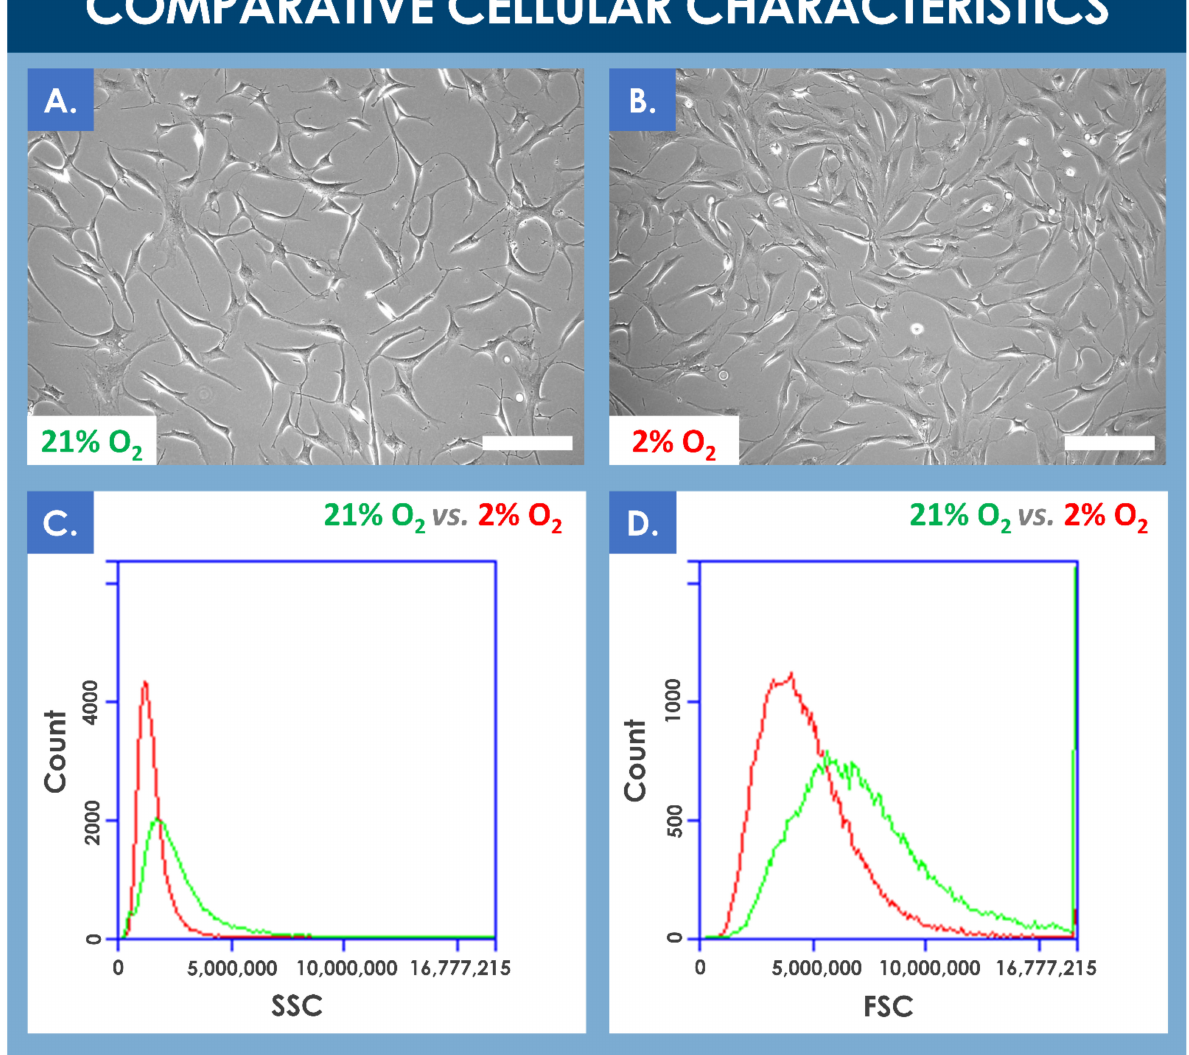
Figure 2. ( A , B ) Comparison of the proliferative cellular morphologies of hFPTs incubated in normoxia conditions (i.e., 5% CO 2 , 21% O 2 ) or in hypoxia conditions (i.e., 5% CO 2 , 2% O 2 ) for 6 days. Scale bars = 200 µ m. ( C ) Comparative SSC plots of hFPTs cultured in hypoxia conditions (i.e., in red) and in normoxia conditions (i.e., in green). SSC or side scatter provides information about granularity and its distribution for the considered cells. Comparative analysis of both population profiles indicated that cell populations cultured in hypoxia were relatively less granular and more homogenous in their granularity distribution. ( D ) Comparative FSC plots of hFPTs cultured in hypoxia conditions (i.e., in red) and in normoxia conditions (i.e., in green). FSC or front scatter provides information about size and its distribution for the considered cells. Comparative analysis of both population profiles indicated that cell populations cultured in hypoxia were relatively smaller in size and more homogenous in their size distribution. The detected signal spike near the upper limit of the FSC channel may have been caused by the presence of large aggregates in the sample from the normoxia group. FSC, forward scatter; hFPT, human fetal progenitor tenocytes; SSC, side